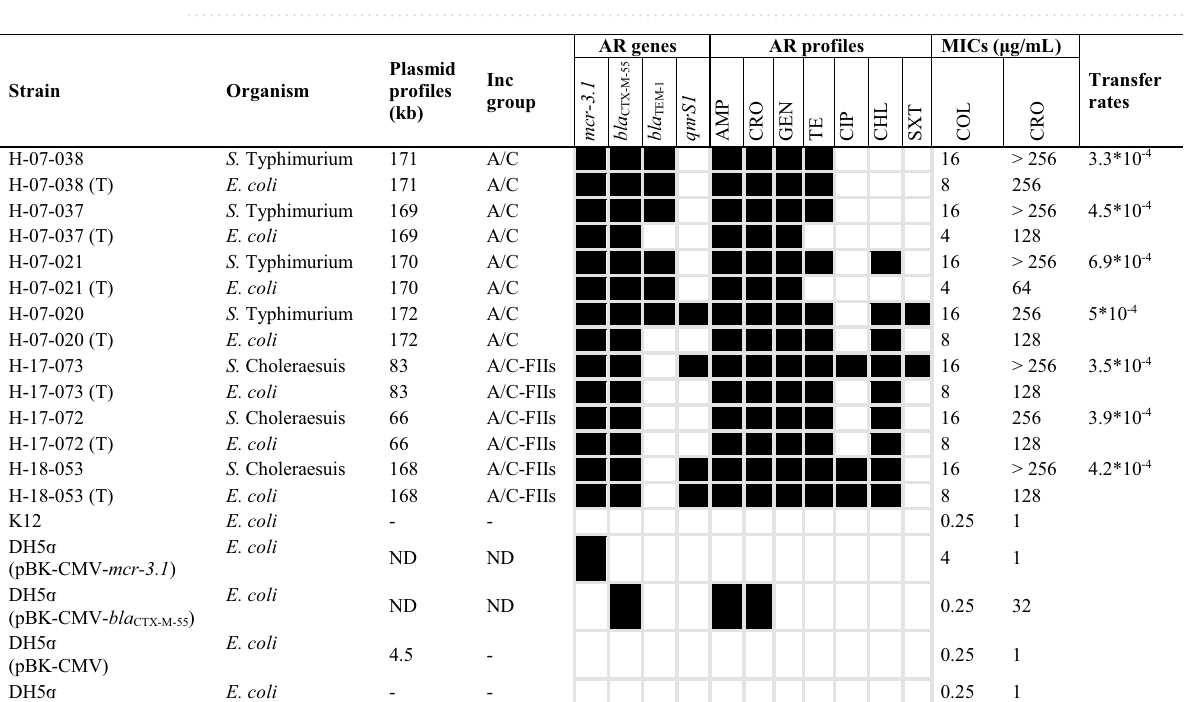
Figure 4. Plasmid profile analysis of nontyphoidal Salmonella isolates with conjugative plasmid carrying the mcr-3 gene together with bla CTX-M-55 gene by S1-PFGE and Southern blot hybridisation. Representative ( a ) PFGE profiles of total DNA digestion with S1 nuclease, and ( b , c ) relative hybridisation with the ( b ) mcr-3 probe and ( c ) bla CTX-M-55 probe. Lane 1, plasmid profile analysis of S. Choleraesuis strain H-17–072; lane 2, S. Choleraesuis strain H-17–073; lane 3, S. Choleraesuis strain H-17–053; lane 4, S. Typhimurium strain H-07–020; lane 5, S. Typhimurium strain H-07–021; lane 6, S. Typhimurium strain H-07–037; lane 7, S. Typhimurium strain H-07–038; lane 8, S. Typhimurium strain H-07–385; lane 9, S. Typhimurium strain H-07–388; lane M, CHEF DNA Size Standard-Lambda Ladder (#170–3635), marker labels are in kilo-bases. Arrows indicate the locations of AMR plasmids.